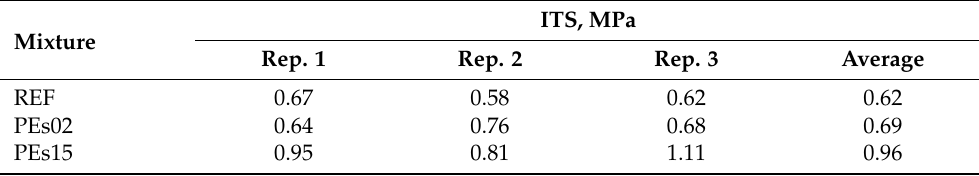
Table 10. The indirect tensile strength (ITS) values for each